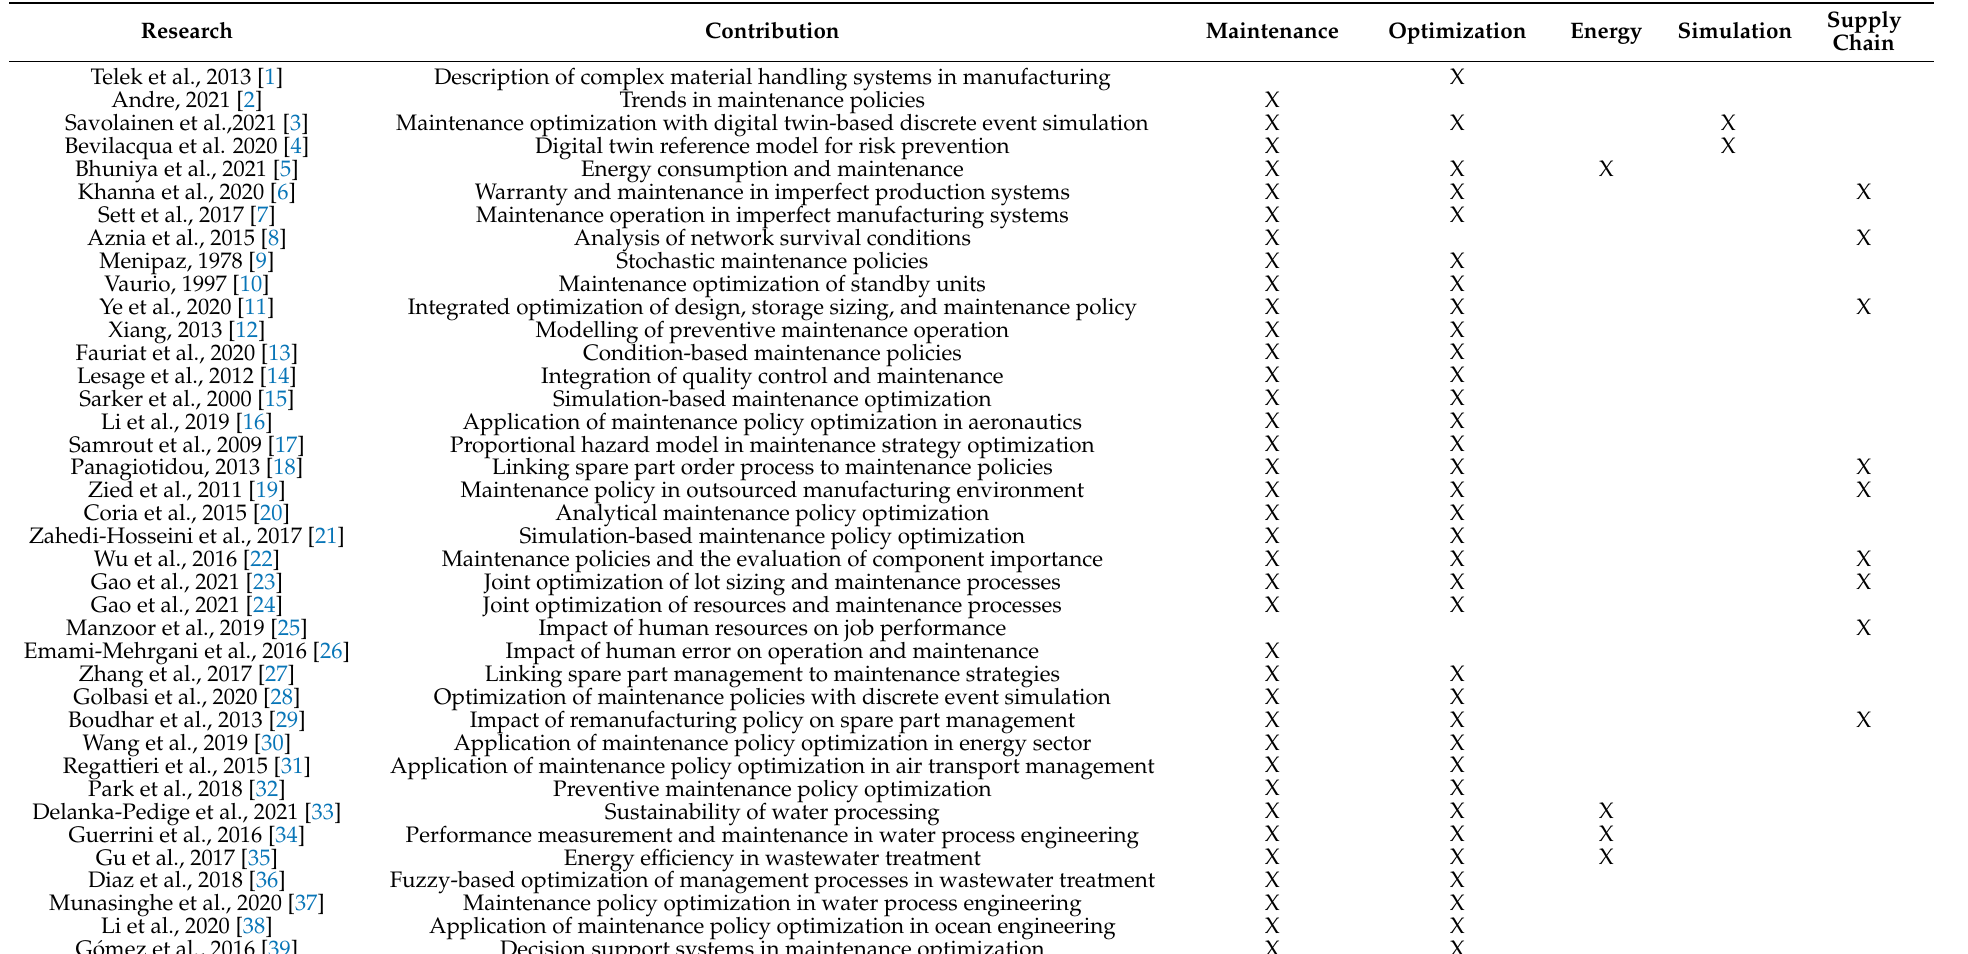
Table A1. Authors’ contributions related to maintenance policy